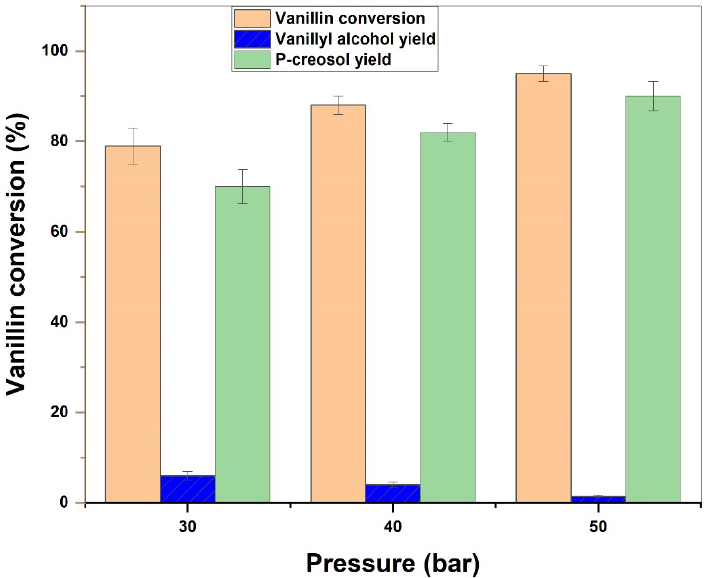
Figure 11. Effect of pressure on the HDO of vanillin (reaction conditions: initial concentration 0.33 M; catalyst 0.6 g; reaction temperature 150 °C; reaction time 9.5 h).